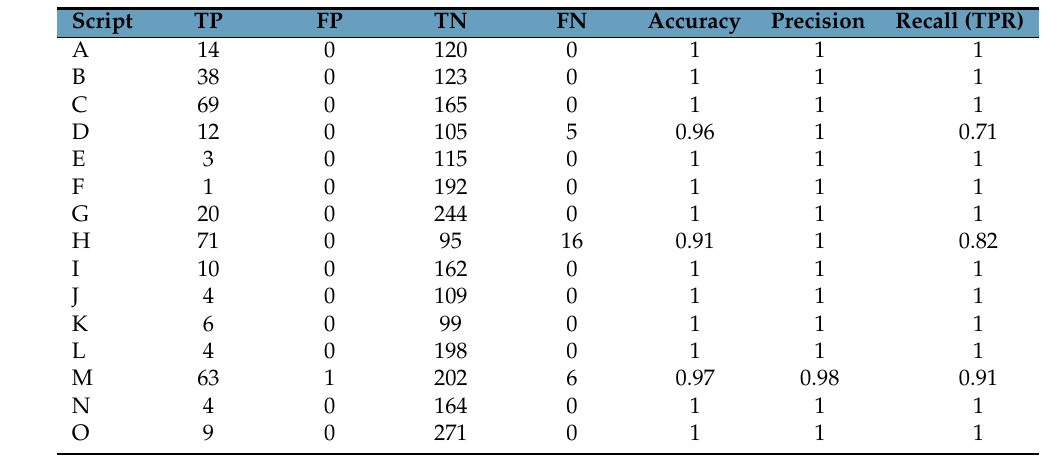
Table 3. Tracker evaluation with GPS-GT data.